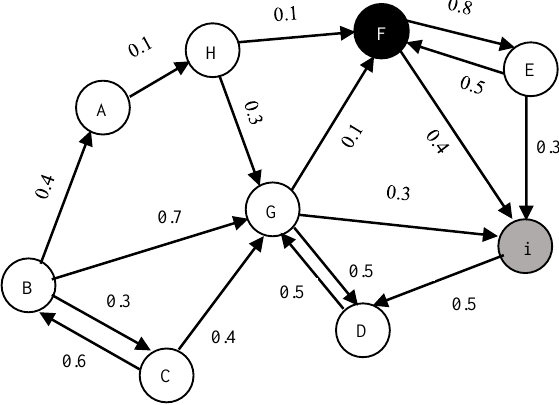
Figure 4. An example for existence of paths between an investigated node (i) and a fraudulent node